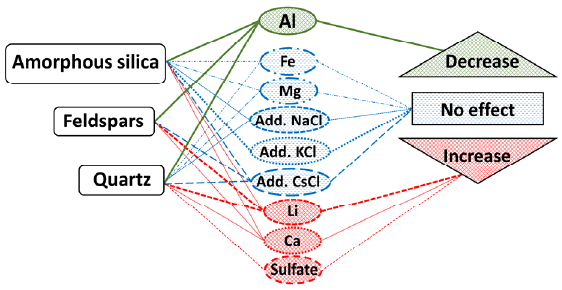
Figure 3. Effect of different ions on the dissolution rate of amorphous silica, quartz and feldspars under alkaline conditions. Adapted from